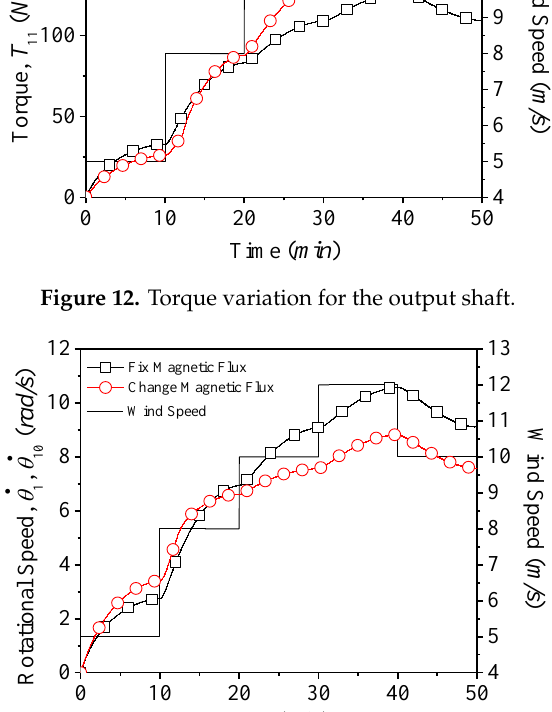
Figure 13. Rotational variation for the input shaft.